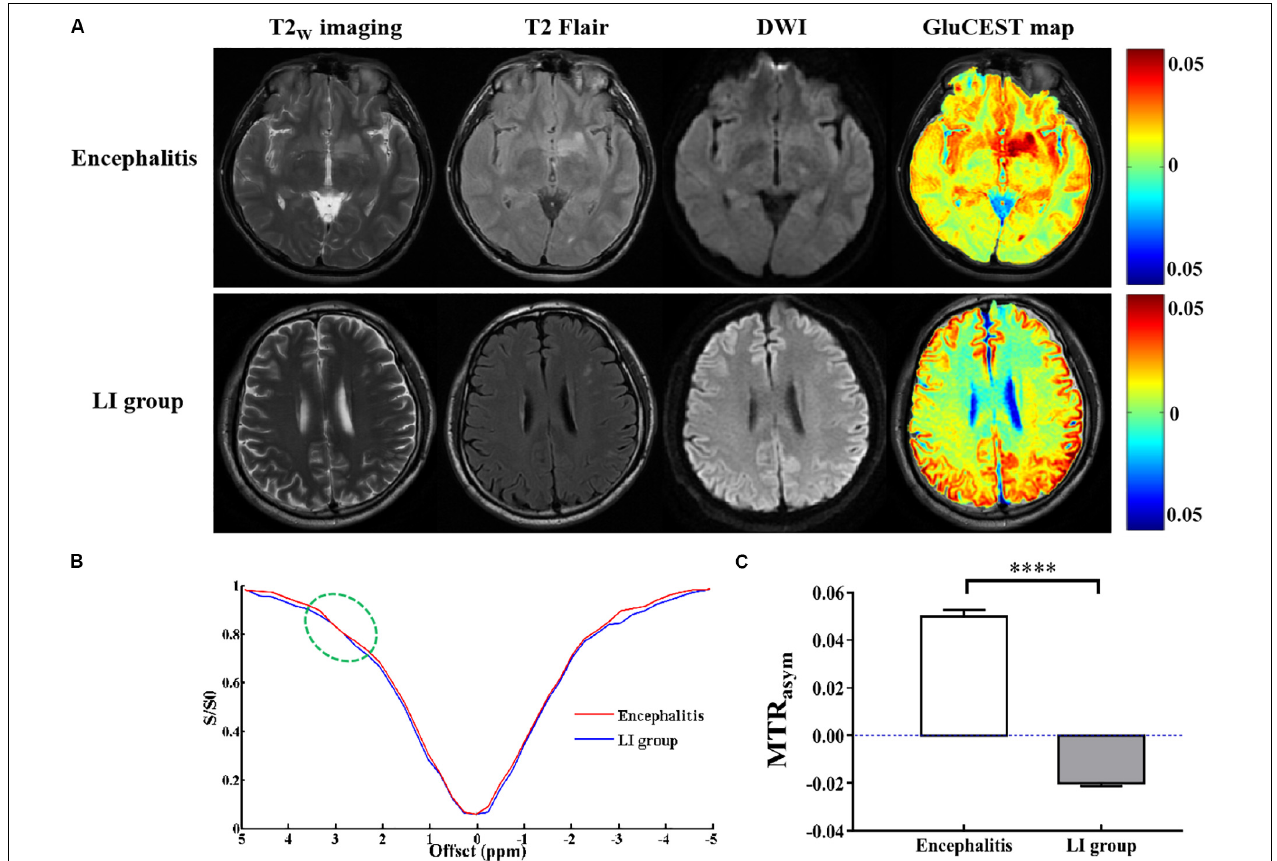
FIGURE 4 | Glutamate chemical exchange saturation transfer imaging in vivo of patients with encephalitis and lacunar infarction. (A) Conventional T2w imaging, T2Flair, and diffusion-weighted images (DWI) could not discriminate encephalitis and lacunar infarction (LI), but GluCEST MRI could distinguish between them. (B) Z-spectrum demonstrated that a small signal dip at 3.0 ppm (green circle) was observed in the inflamed regions but not observed in the LI regions, indicating that inflammation is a cause of the elevated local glutamate concentration. (C) GluCEST signal was elevated in patients with encephalitis and decreased in patients with LI ( n = 6, Student’s t test, two-tailed, unpaired, **** p < 0.0001).